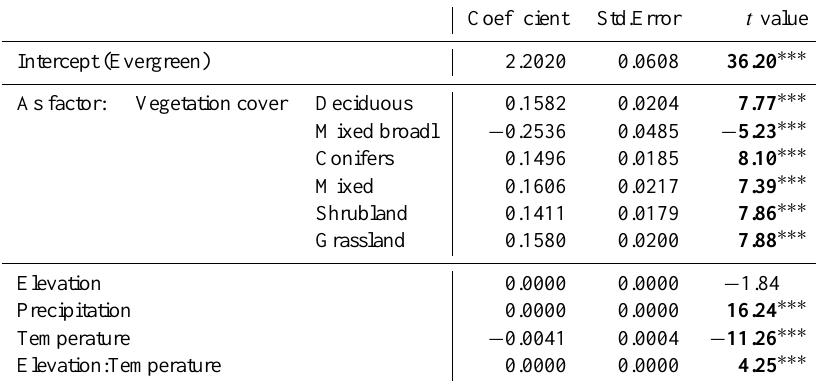
Table 2. Coefficients of the linear model used to test the effects of vegetation cover, elevation, precipitation, temperature and the interaction between elevation and temperature on SOC content (3rd root transformed). For all explanatory factors of the categorical variable vegetation cover, one level was considered the reference (evergreen), the effect for which was incorporated in the model intercept term, and the effect of all other levels was considered relative to the reference. Therefore, considering the coefficient of the intercept as a baseline, the rest of the coefficients indicate the sign and degree of influence in relation to this reference value. Bold values indicate that the correlation coefficient differs significantly from zero ( ∗ p <0.05, ∗∗ p <0.01, and ∗∗∗ p <0.001). Coefficient